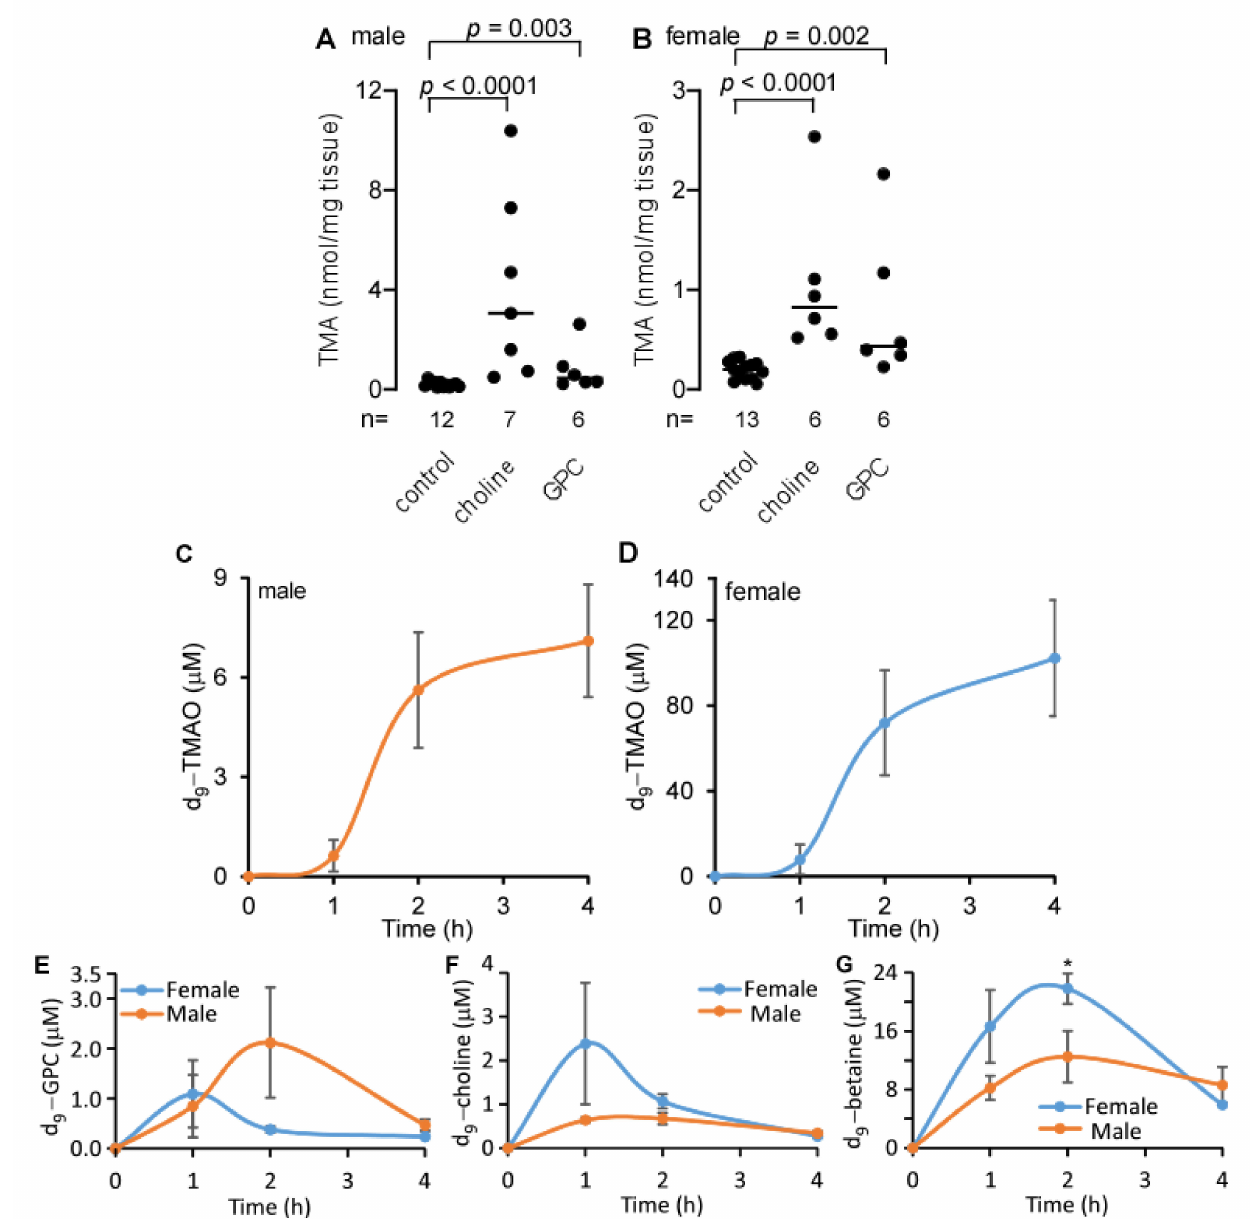
Figure 5. GPC supplementation increases cecal TMA and plasma TMAO production. ( A , B ) Cecal TMA content in LDLr − / − male ( A ) and female ( B ) mice fed choline, GPC supplemented chow diet, and control chow diet for one month. p values were calculated by Wilcoxon rank sum test. ( C , D ) Production of d 9 -TMAO in plasma of Apoe − / − male ( C ) and female ( D ) mice after oral gavage with 150 µ L 150 mM d 9 -GPC. ( E – G ) Plasma d 9 -GPC, d 9 -choline, and d 9 -betaine in Apoe − / − male and female mice after oral gavage with 150 µ L 150 mM d 9 -GPC. Data are presented as mean ± SE from five male and five female mice in each group ( C – G ). * p < 0.05 for comparison between male and female mice, determined by Student’s t